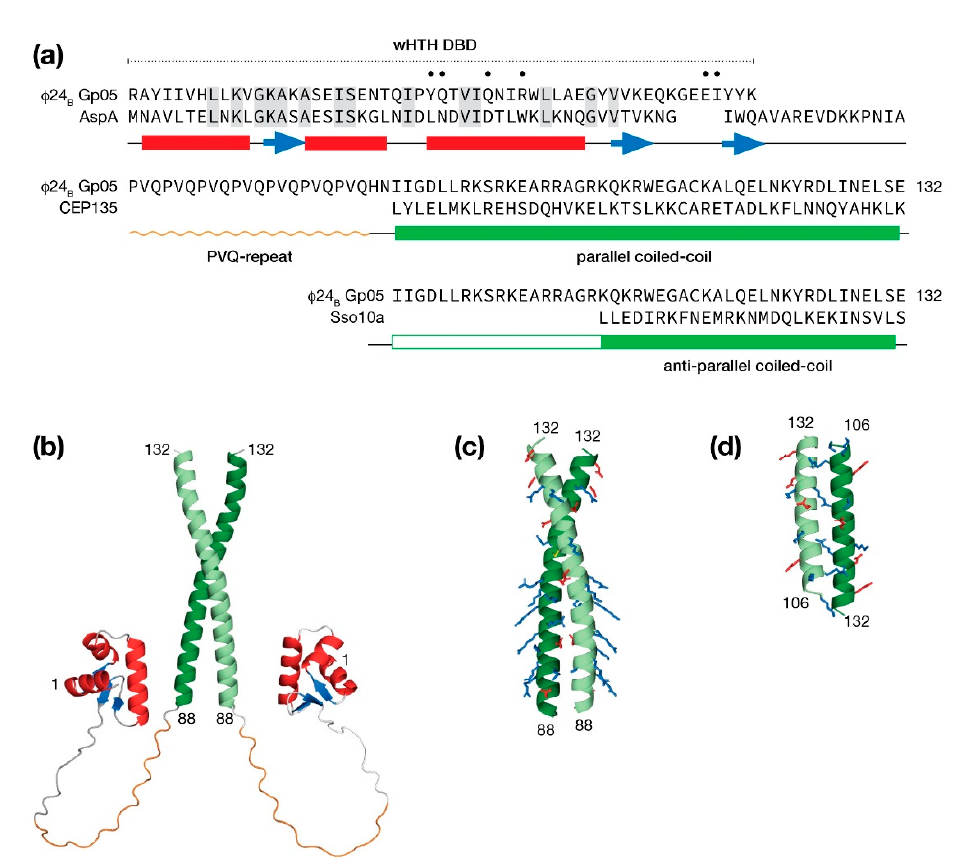
Figure 9. Molecular modeling the multidomain protein Gp05 from the Stx + phage Φ 24 B . ( a ) The protein may be considered in terms of a winged helix-turn-helix (wHTH) DNA binding domain (DBD), a proline-valine-glutamine (PVQ) repeat region and a coiled-coil region. Predicted helices (bars) and strands (arrows) are shown below the sequence. An alignment with a similar wHTH domain from the AspA centromere binding protein (PDB: 5K5R) is shown for comparison. Sequence identity is denoted by shading, a dot indicates amino acids that are predicted to make DNA base contacts. Following the PVQ-repeat, the coiled-coil domain was modeled either as parallel coiled-coil spanning the entire predicted region against the human centriolar protein CEP135 (PDB:5FCN) or as an anti-parallel coiled-coil partially spanning the predicted region against the Solfolobus chromosomal maintenance protein Sso10a (PDB: 1R7J). ( b ) A representative full model of dimeric Gp05 determined by AlphaFold with a coiled-coil region in a parallel configuration. ( c ) A molecular model of the Gp05 coiled-coil domain in a parallel configuration determined using the Rosetta software suite. Charged amino acids are shown in sticks representation. ( d ) A molecular model of a partial Gp05 coiled-coil domain in an anti-parallel configuration determined using the Rosetta software